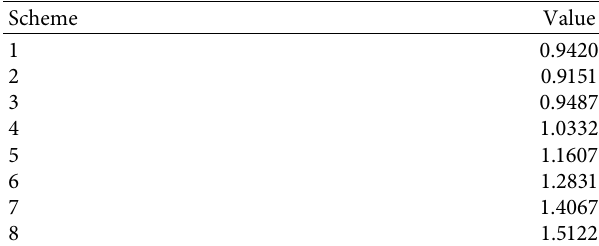
Table 10: Bull’s eye distance of different schemes. Scheme